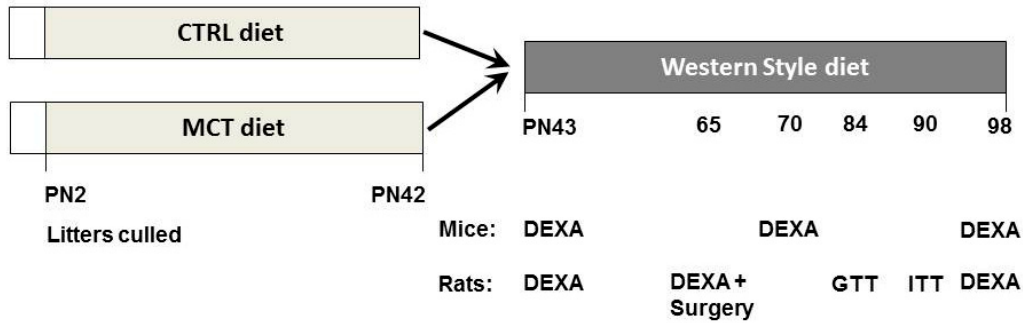
Figure 1. Experimental design of the rat and mouse study. Litters were randomized and culled on postnatal (PN) day two, and were exposed to a CTRL or MCT diet ( n = 3 litters/diet). Male pups continued their respective diets after weaning (on PN day 21) until they were switched to a western style diet (WSD) on PN day 42. Body composition was monitored by dual X-ray absorptiometry (DEXA) at the indicated time points. Rats were equipped on PN day 65 with a jugular vein cannula to enable repeated stress-free blood sampling for the purpose of an intravenous glucose (GTT) and insulin (ITT) tolerance test on PN day 84 and 90, respectively.